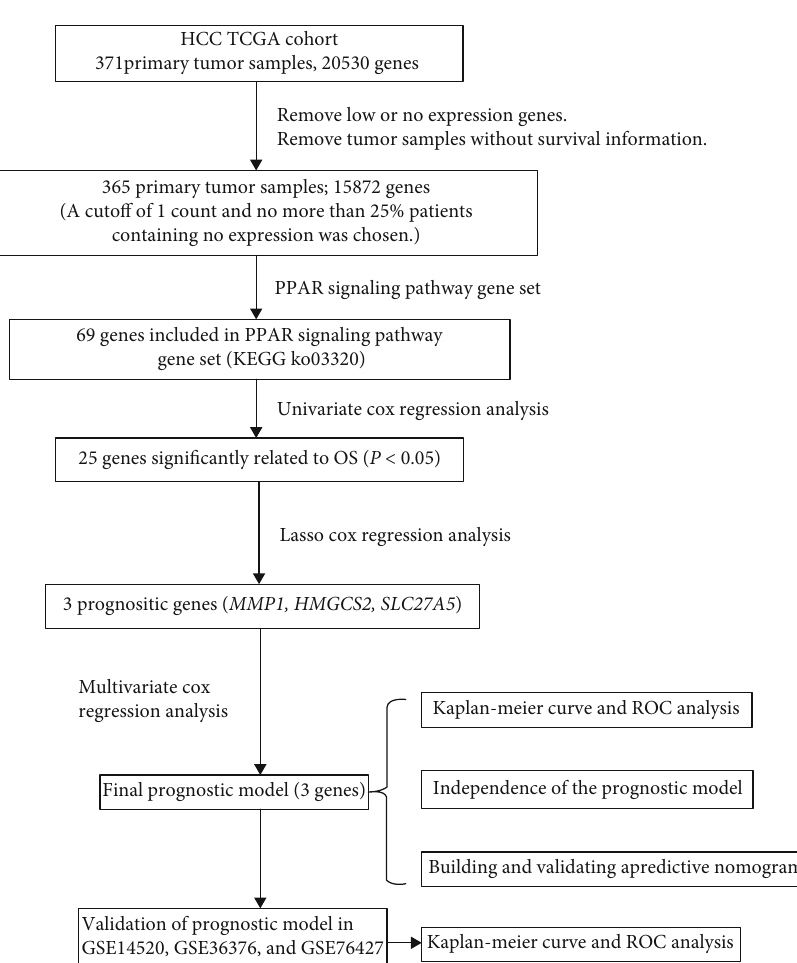
Figure 1: The fl ow chart about the study of PPAR-related gene signature in predicting survival of